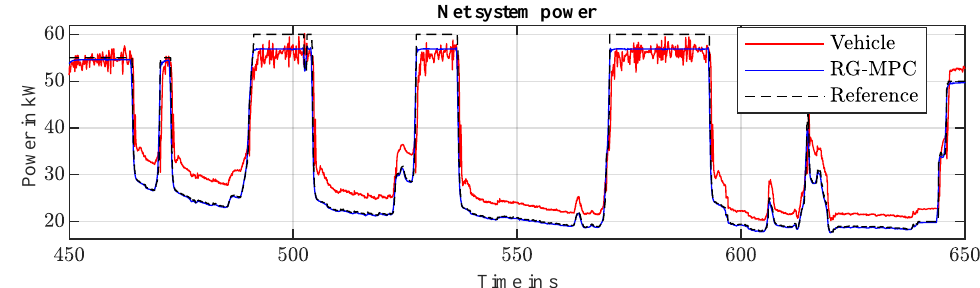
Figure 7. Net system power. Comparison between the vehicle operation and RG-MPC.